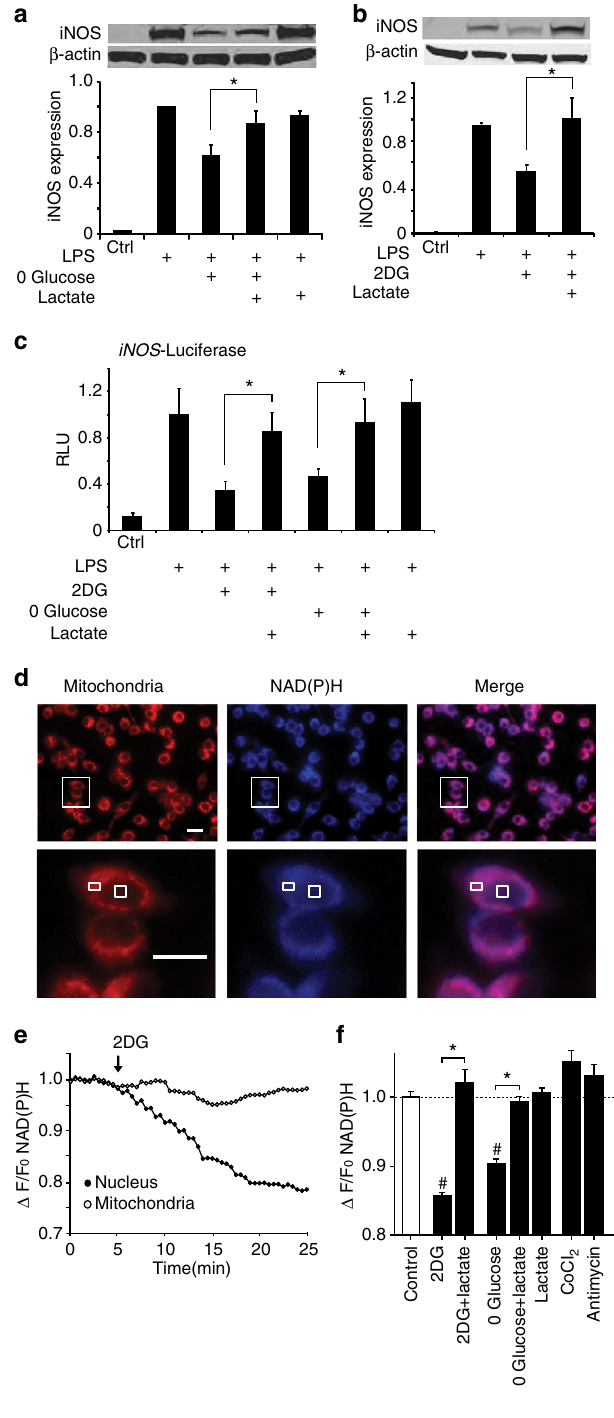
Fig. 3 Lactate reverses the effects of glycolytic inhibition on both cytosolic NADH levels and LPS-induced iNOS expression. a , b The effects of glucose- free medium and 2DG on LPS-induced iNOS expression are reversed by Supplementary Fig. 3. c The effects of glucose-free medium and 2DG on LPS-induced iNOS transcription are reversed by 20 mM lactate, as measured by relative light units (RLU) emitted by a cells transfected with a luciferase-coupled iNOS reporter gene. n = 3; * p < 0.05. d Effects of lactate on cytosolic NAD(P)H levels as measured by intrinsic fl uorescence ( blue ). Mitochondria are labeled with Mitotracker ( red ). Lower row images are enlarged views of areas de fi ned by rectangle in upper row. Boxes in lower row identify a mitochondria-rich peri-nuclear region and a mitochondria-free nuclear region in one cell. e Example of real-time NAD(P)H fl uorescence changes recorded from these two regions during incubation with 1 mM 2- deoxyglucose (added at arrow ). f Quanti fi ed results showing relative cytosolic NAD(P)H fl uorescence changes induced by incubation with 1 mM 2-deoxyglucose ± 20 mM lactate, glucose-free medium ± 20 mM lactate, 20 mM lactate, 200 µ m cobalt chloride, or 1 µ m antimycin